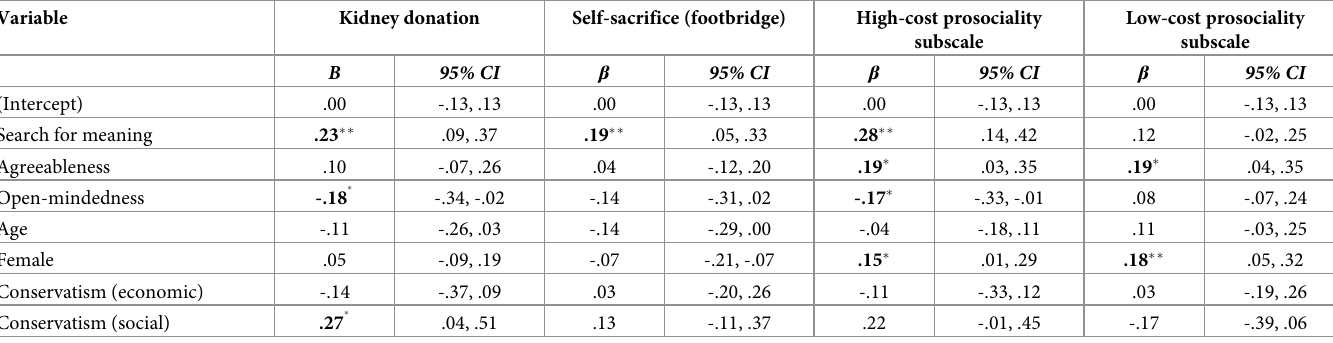
Table 8. Multiple regressions predicting costly prosociality with search for meaning in Study